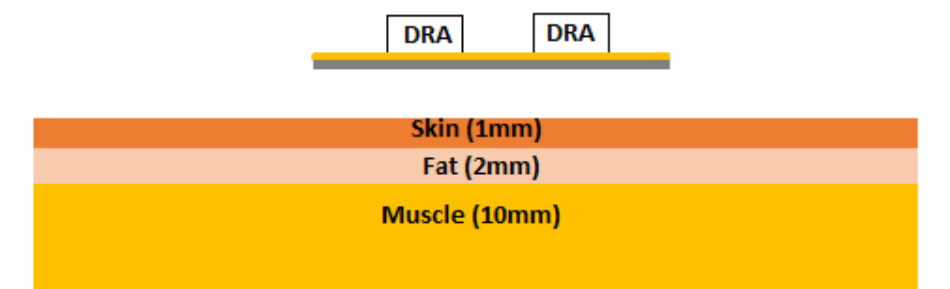
Figure 10. Cross-section view of a DRA array next to the body phantom.